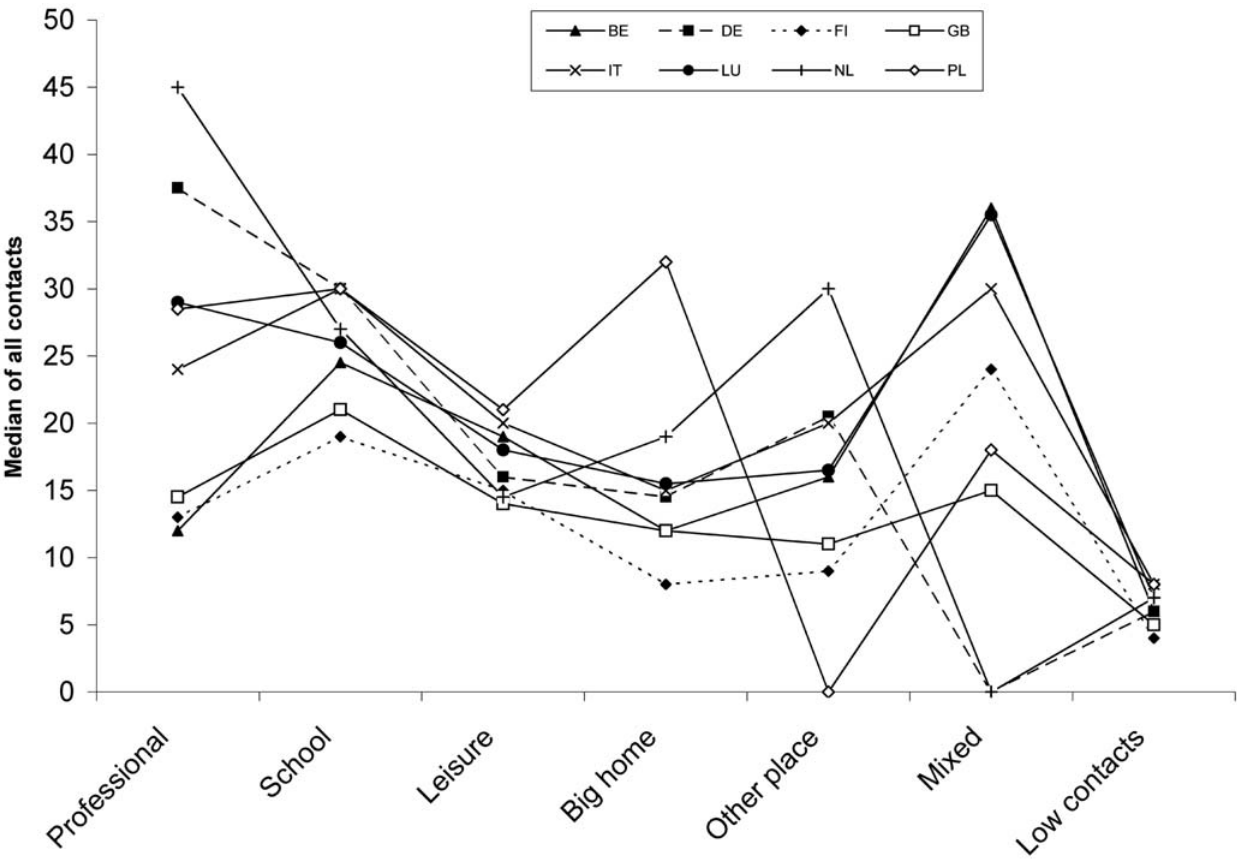
Figure 2. Median numbers of contacts for each cluster by country.